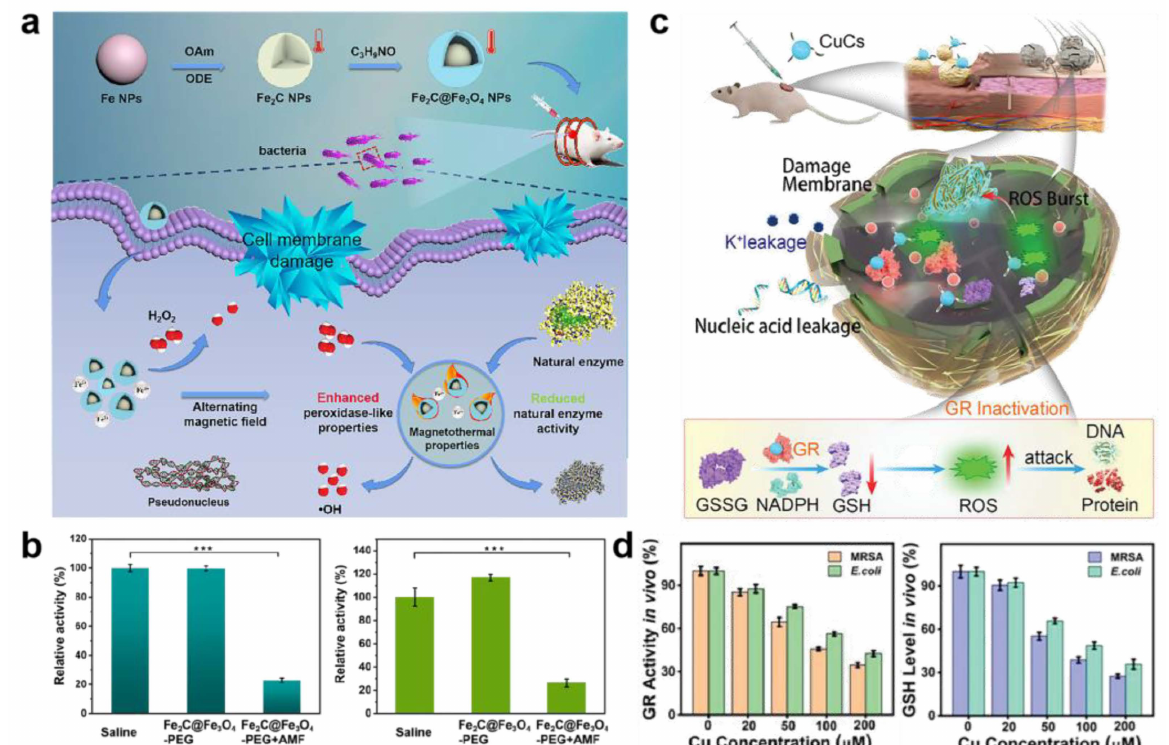
Figure 6. Protein destruction by metal oxide nanomaterials. ( a ) Schematic illustration of preparation process and antibacterial mechanism of Fe 2 C@Fe 3 O 4 -PEG thermogenic nanozyme. ( b ) The activity of glutathione reductase (GR, left ) and adenosine triphosphatases ( right ) after different treatments. *** indicate obvious differences at p < 0.001. ( c ) Scheme of copper clusters (CuCs) healing local MRSA skin wound infection. ( d ) Enzymatic activity of GR and reduced glutathione levels in MRSA and E. coli after treatment with CuCs. GSSG, glutathione disulfide; GSH, reduced glutathione; ROS, reactive oxygen species; NADPH, nicotinamide adenine dinucleotide